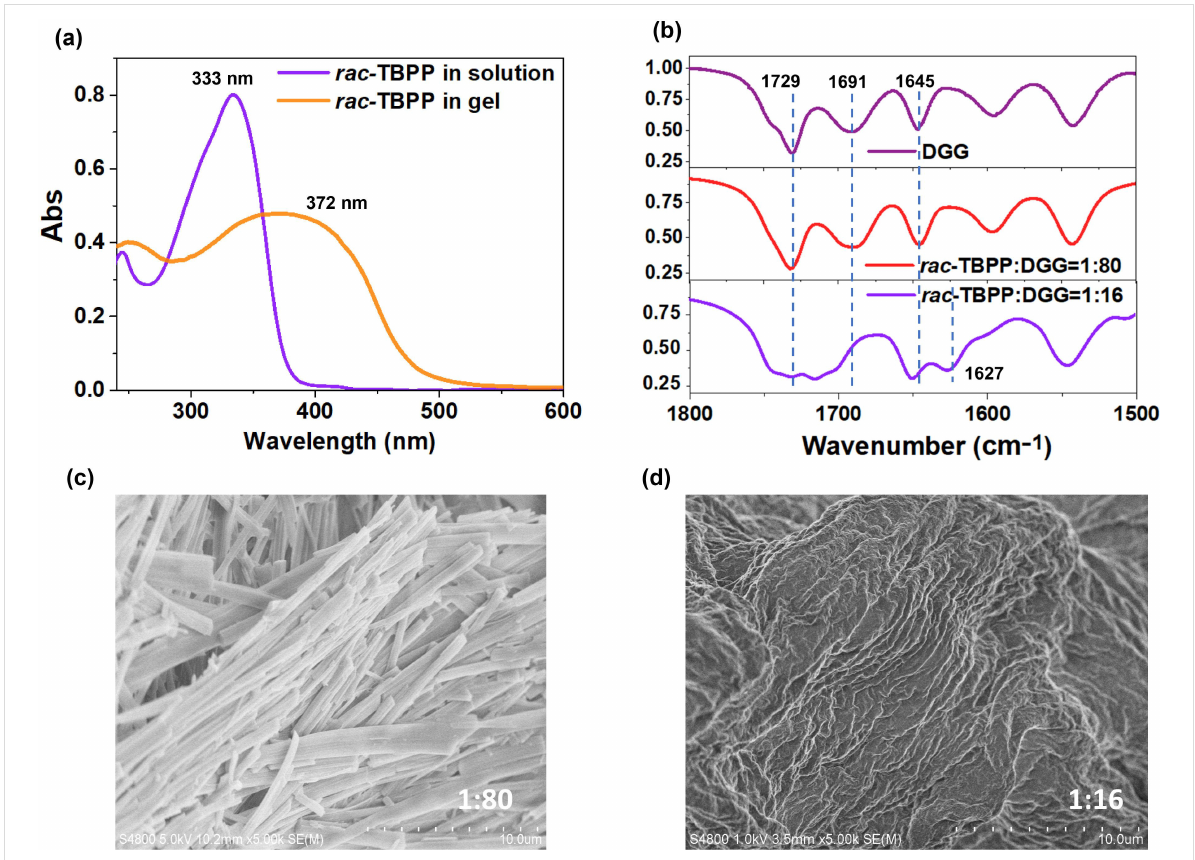
Figure 3: (a) UV–vis absorption spectra of rac- TBPP and rac- TBPP / DGG co-gel ( rac- TBPP / DGG = 1:80). (b) FTIR spectra of DGG and rac- TBPP / DGG co-gels at molar ratios of 1:80 and 1:16, respectively. SEM images of rac- TBPP / DGG co-gels at molar ratios of 1:80 (c) and 1:16 (d).